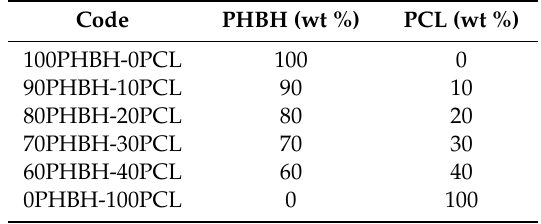
Table 1. Code and composition (wt %) of binary blends of poly(3-hydroxybutyrate- co -3- hydroxyhexanoate) / poly( ε -caprolactone) (PHBH / PCL)